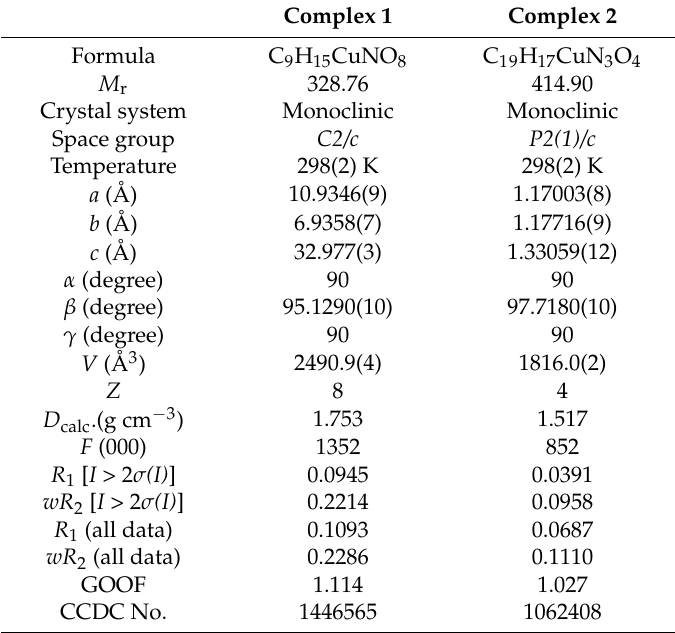
Table 1. Crystallographic data for Complexes 1 and 2 . GOOF: Goodness of fit test; CCDC: Cambridge Crystallographic Data